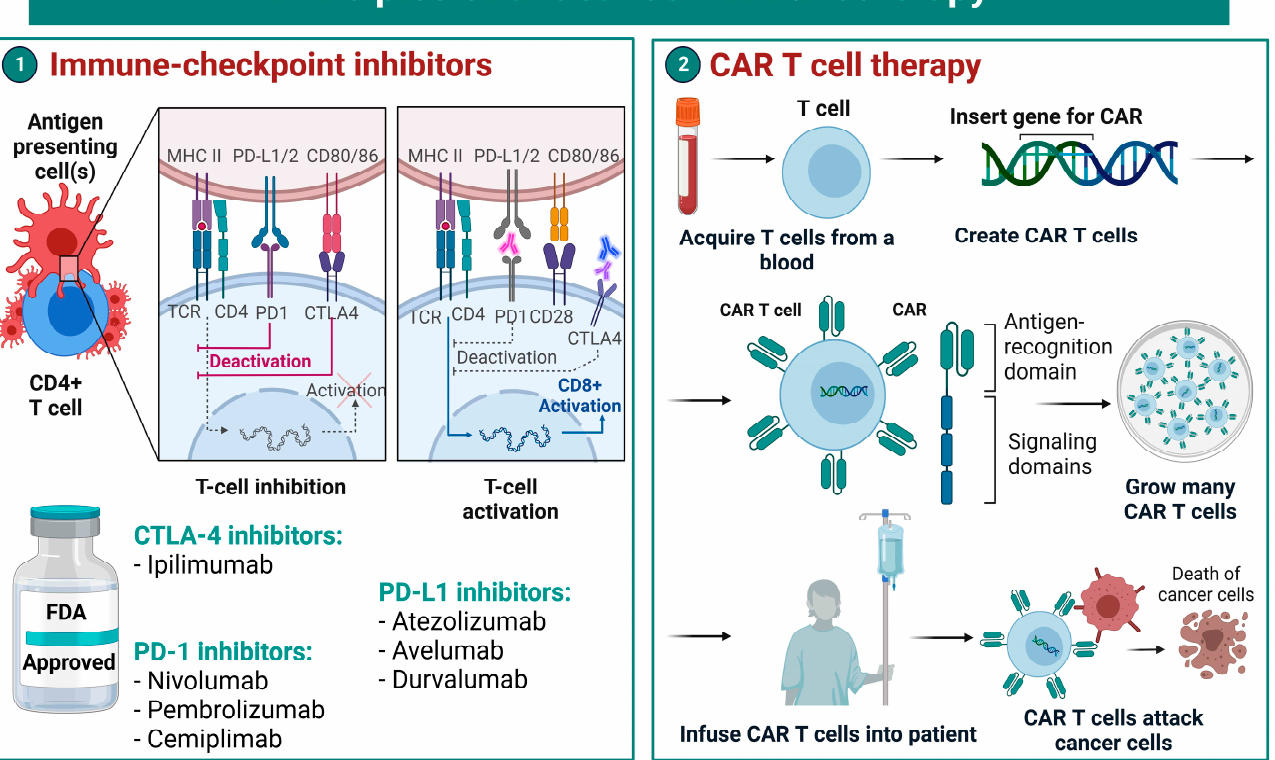
Figure 2. Overview of mechanisms of immune-checkpoint inhibitors and CAR T-cell therapy.